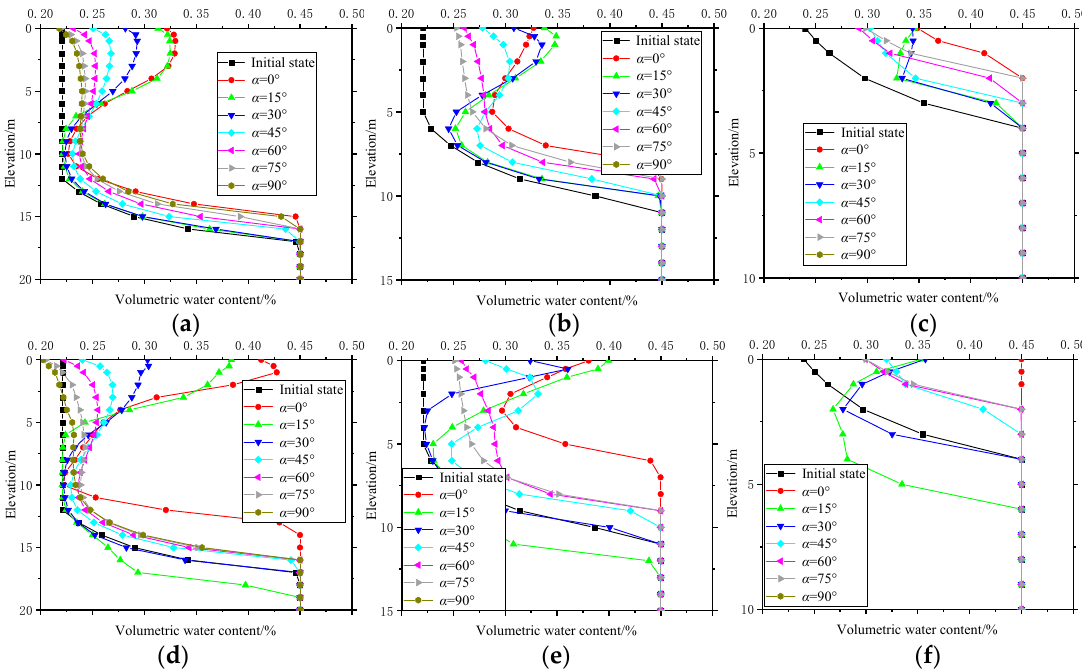
Figure 5. Variation of volumetric water content under different α values for sandy soil. ( a ) Top of the slope with k r = 10. ( b ) Middle of the slope with k r = 10. ( c ) Toe of the slope with k r = 10. ( d ) Top of the slope with k r = 100. ( e ) Middle of the slope with k r = 100. ( f ) Toe of the slope with k r = 100.